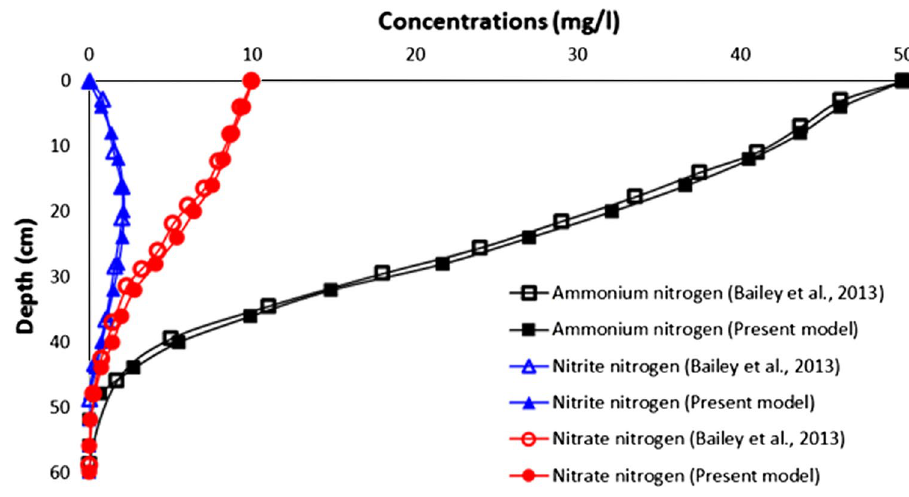
Fig. 3 Influence of sorption and biodegradation in a ammonium nitrogen and b nitrate nitro- gen at the end of 10 days of wastewater application (refer to Tables 2 and 3 for other